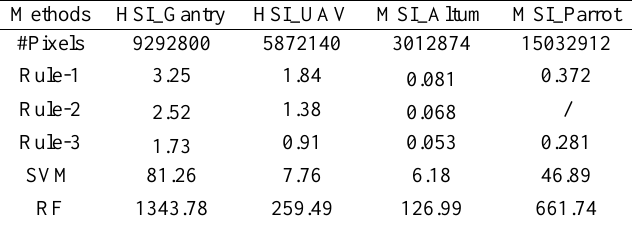
Table 4. Comparison of processing time of different methods (processing time unit: minutes).